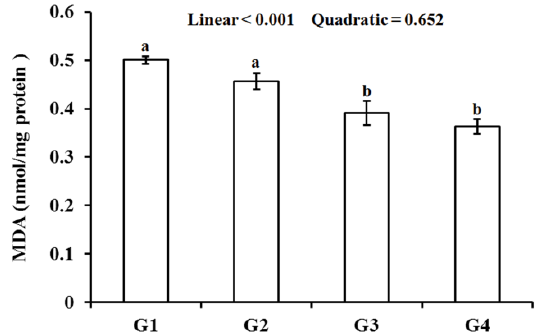
Figure 1. Effect of Gln on MDA of the breast muscle in heat-stressed broilers. a, b: Values in columns with different letters differ significantly ( p < 0.05). Broilers in the G1, G2, G3, and G4 groups were housed in the hot environment and fed the basal diet with 0, 0.5%, 1.0%, and 1.5% Gln, respectively.